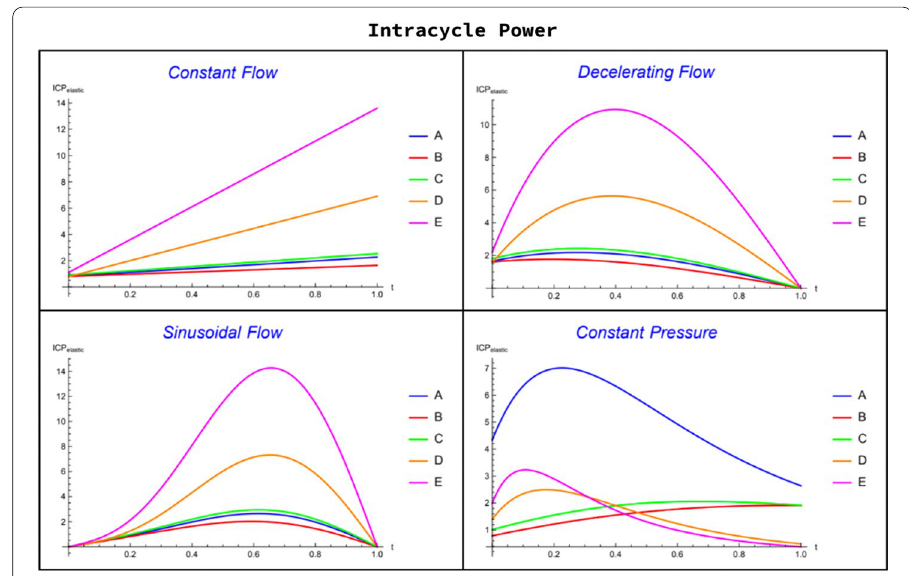
Fig. 3 Comparison of inspiratory compartmental intracycle elastic power (ICP elastic ) for all labeled modes of ventilation: constant inspiratory flow (CF), decelerating inspiratory flow (DF), constant inspiratory pressure (CP), sinusoidal inspiratory flow